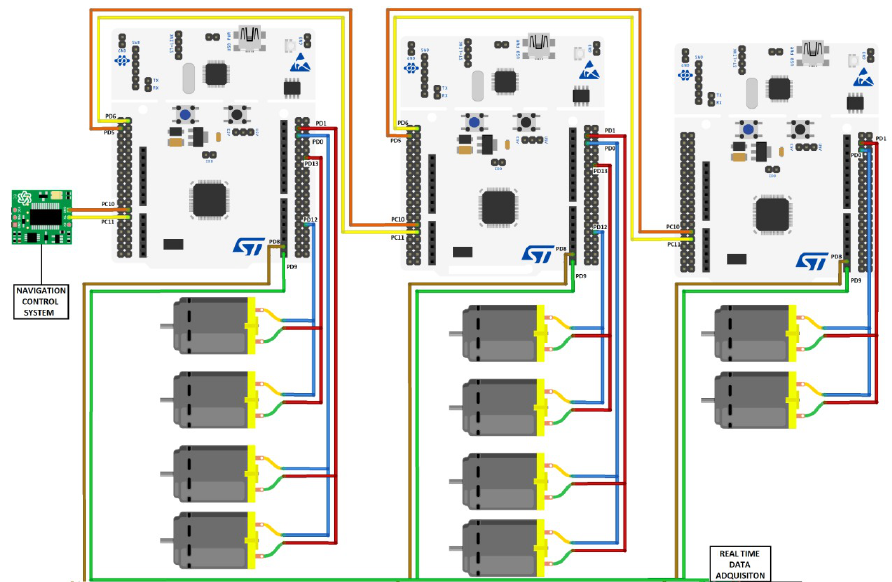
Figure 16. Connection diagram for the system control.